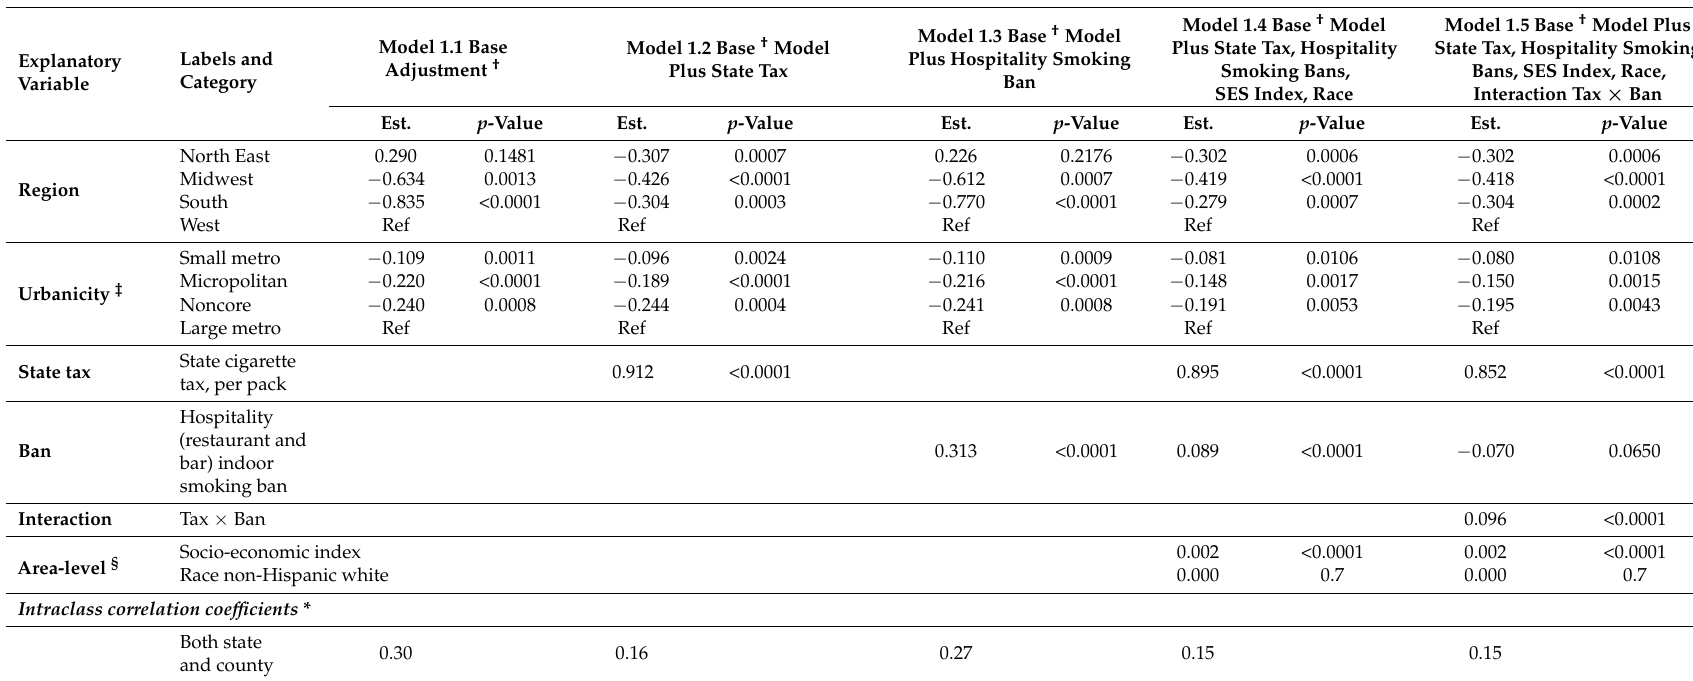
Table 2. Mean differences in store-level cigarette prices per pack; data from 2001 to 2011, n = 2973 chain supermarkets and convenience stores; estimates are derived from a random intercept model *